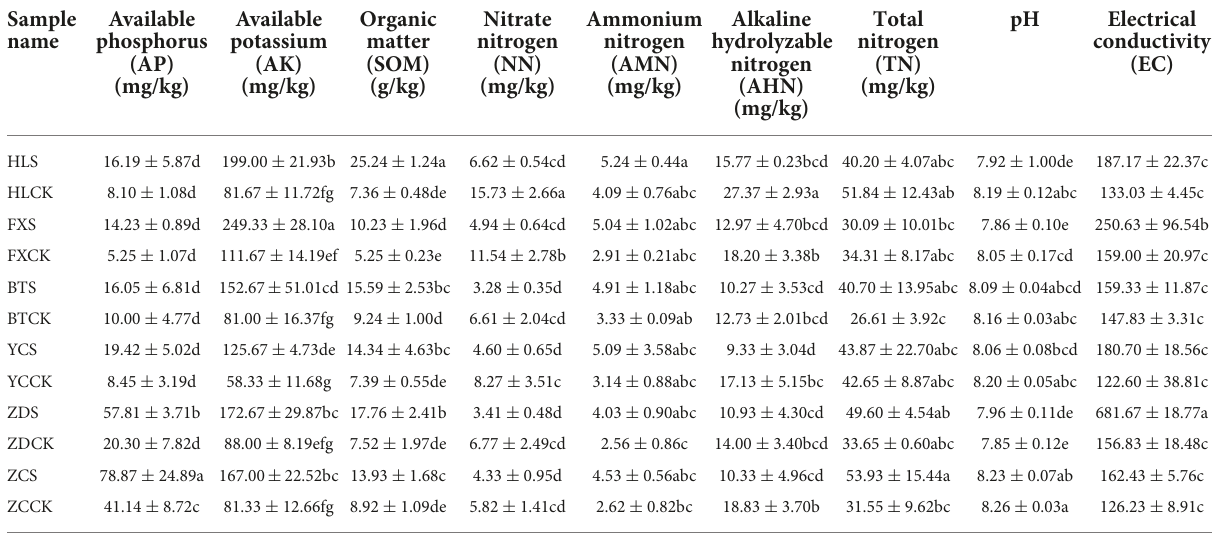
TABLE 1 Soil physicochemical property of each